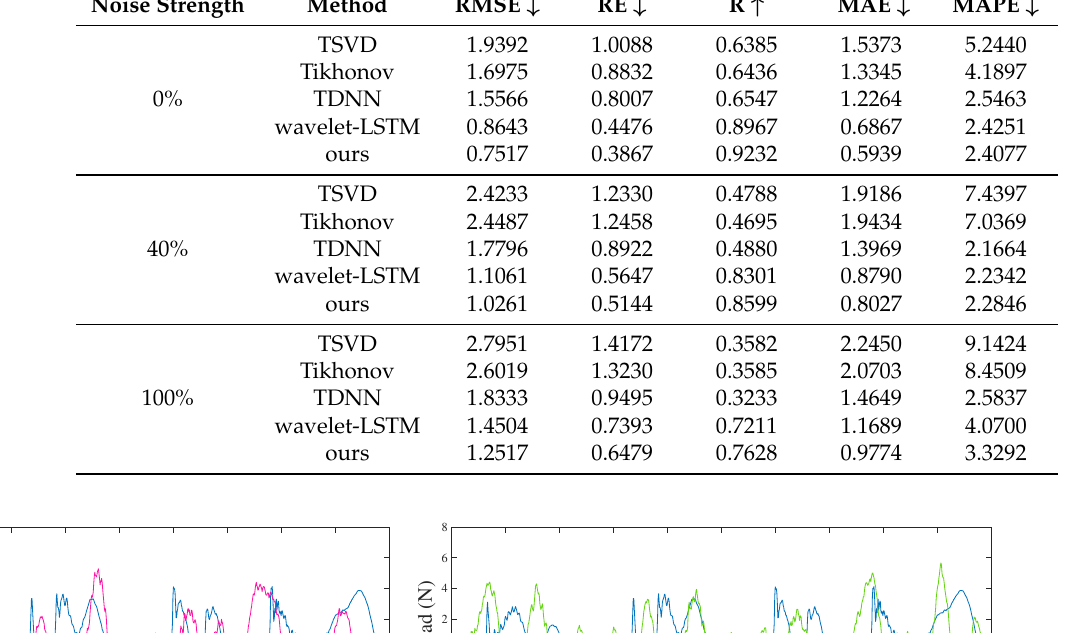
Table 6. Quantitative comparisons on different methods.